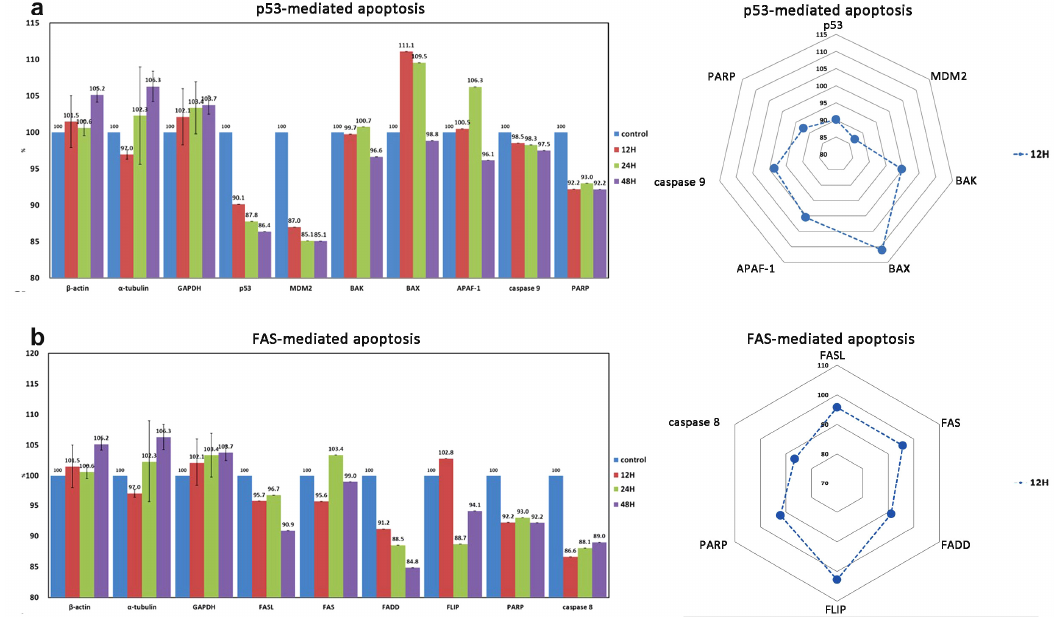
Figure 5. ( a ) Changes to p53 mediated apoptosis-related proteins after PTX treatment in RAW 264.7 cells; ( b ) changes to FAS-mediated apoptosis-related proteins after PTX treatment in RAW 264.7 cells. Left-sided graph shows changes to protein expression according to the application time of PTX, blue bar; control group, red bar; 12 h treatment of PTX, green bar; 24 h treatment of PTX, purple bar; 48 h treatment of PTX. Right-sided polygonal graph shows protein expression profiles after 12 h treatment of